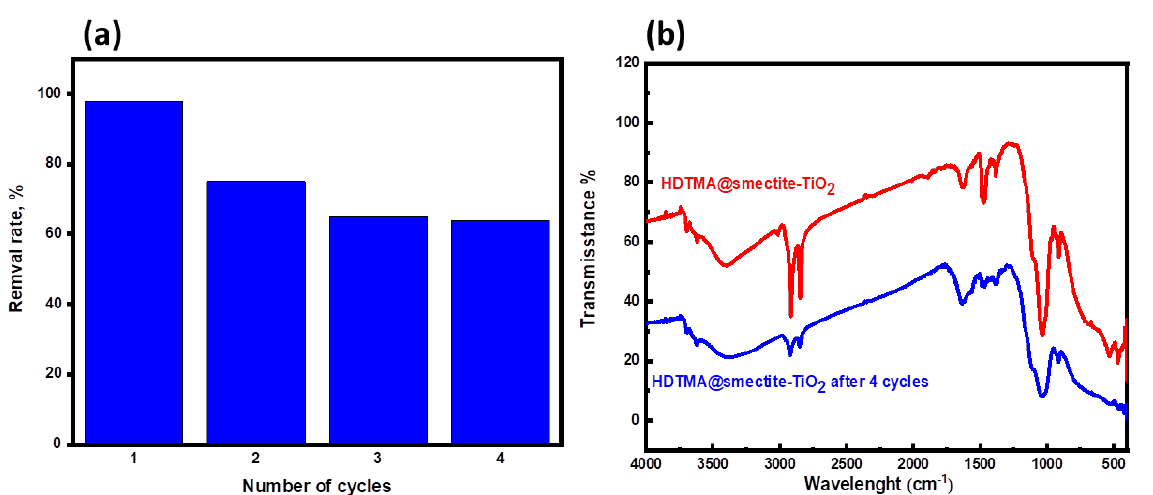
Figure 6. ( a ) Recyclability of HDTMA@Smectite-TiO 2 for four photocatalytic cycles. ( b ) FTIR spectra of HDTMA@SmectiteTiO 2 of samples before and after photodegradation.